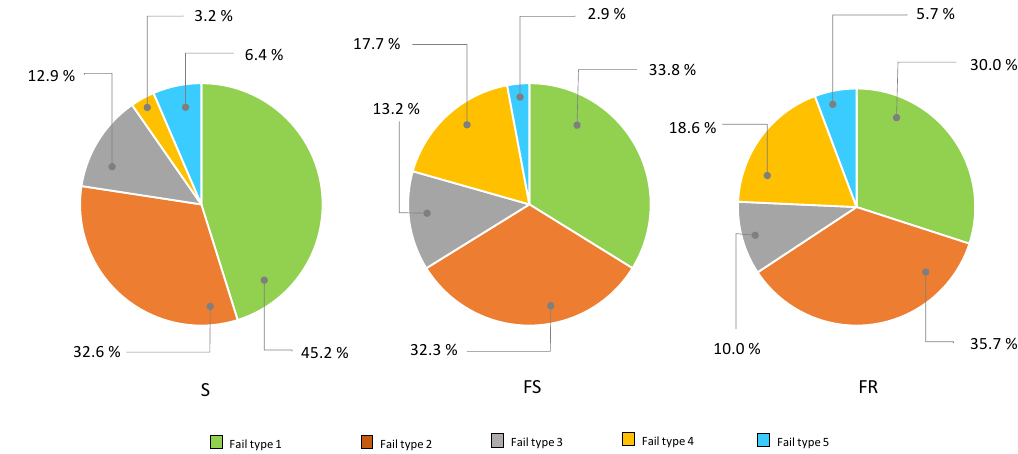
Figure 9. Distribution of unsuccessful grafts according to di ff erent cause, depending on the orientation in which the process is undertaken. Fail type 1: Stem tip bent over on itself. Fail type 2: Scratches in guiding and positioning. Fail type 3: Separation between stems (not well-joined). Fail type 4: Pinching o ff the clip. Fail type 5: Other non-appreciable failures in the grafting process. Consequently, the best grafting strategy tested to carry out the splicing graft was order-dependent; that is to say, positioning the seedlings first, and then fitting the grafting clip. It also depends on the seedling orientation, placing the union line perpendicular to the clip opening (Figure